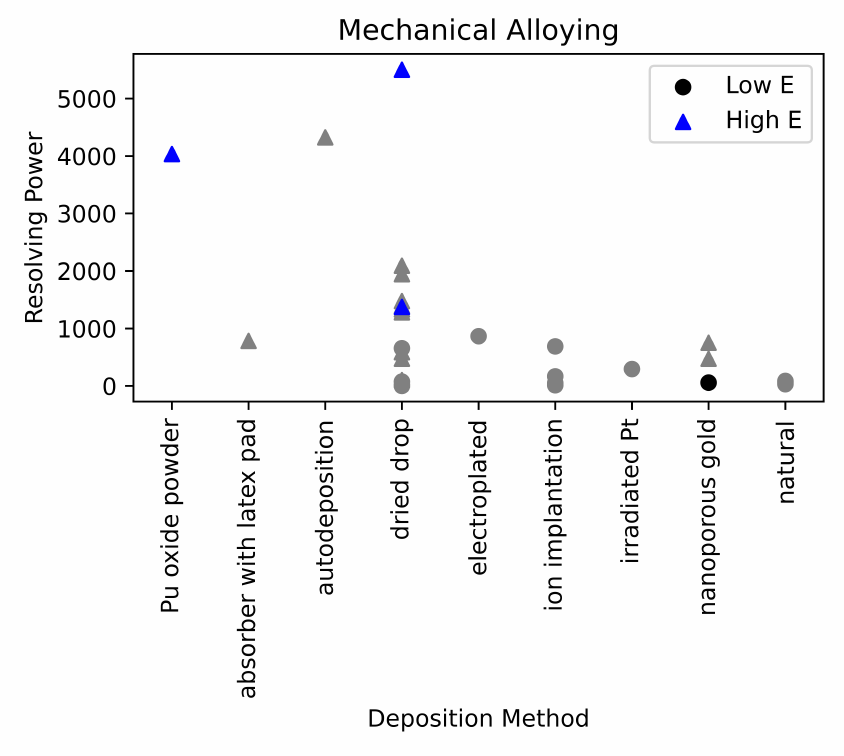
Figure 9. Detector resolving power as a function of deposition method. The effects of mechanical alloying are highlighted